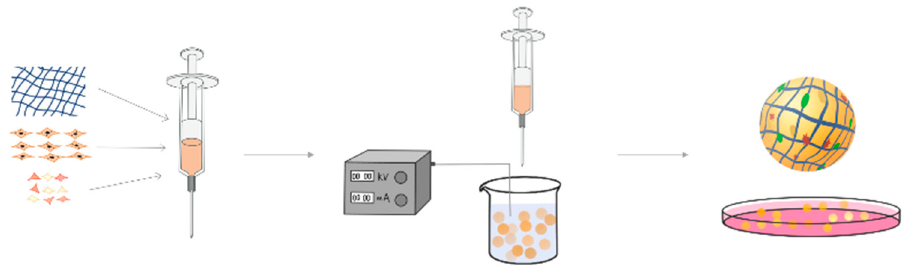
Figure 2. Application of hydrogel microspheres in pulp